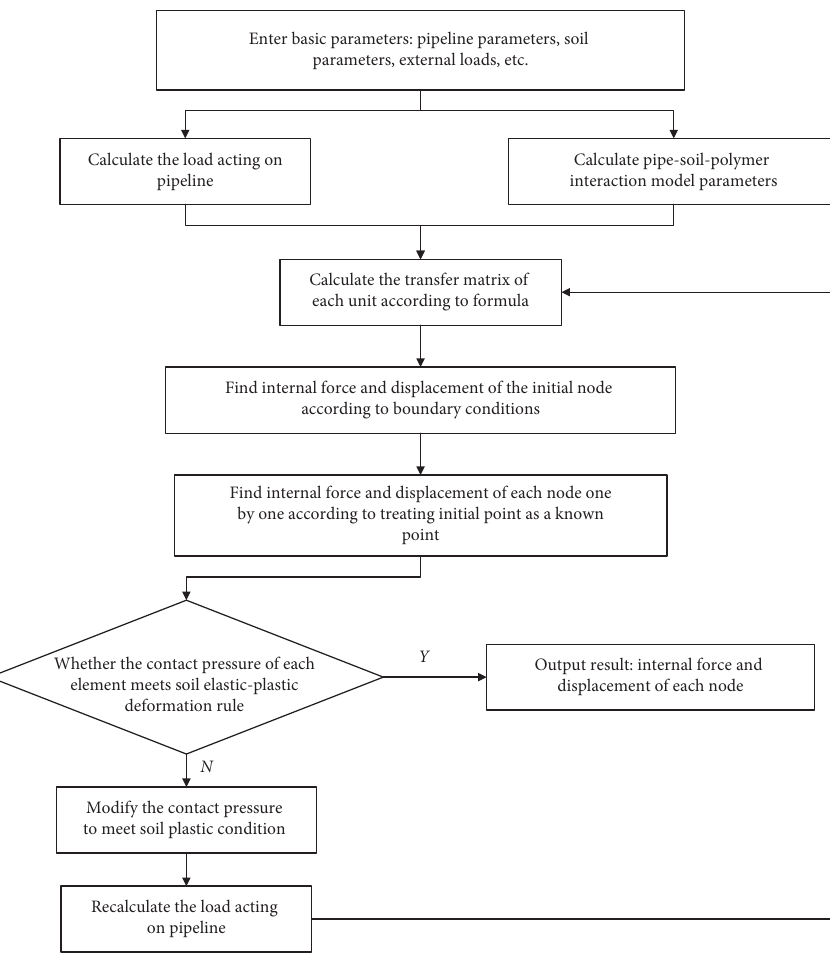
Figure 7: Flowchart of the pipeline stress calculation Table 1: Performance parameters of the pipeline, soil, and polymer used in the experiment. Material